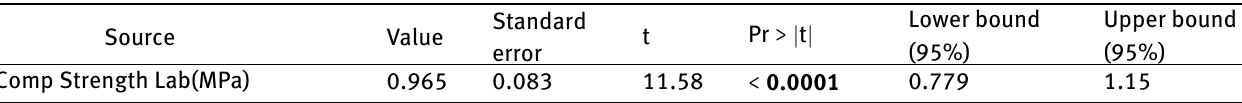
Table 12: Standardized coefficients (Compressive Strength Model (MPa))